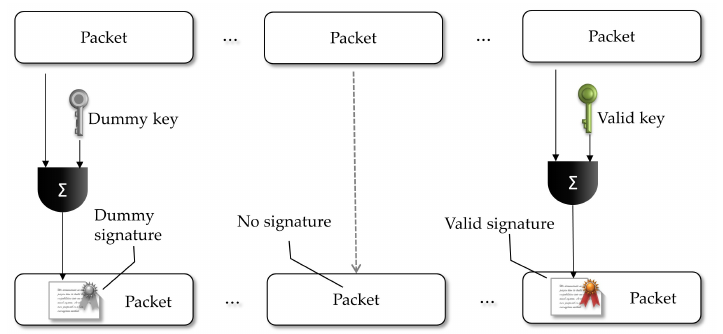
Figure 6. The proposed mode of generating packets signatures by the sender, thus producing packets with dummy and coherent signatures and packets with no signature.